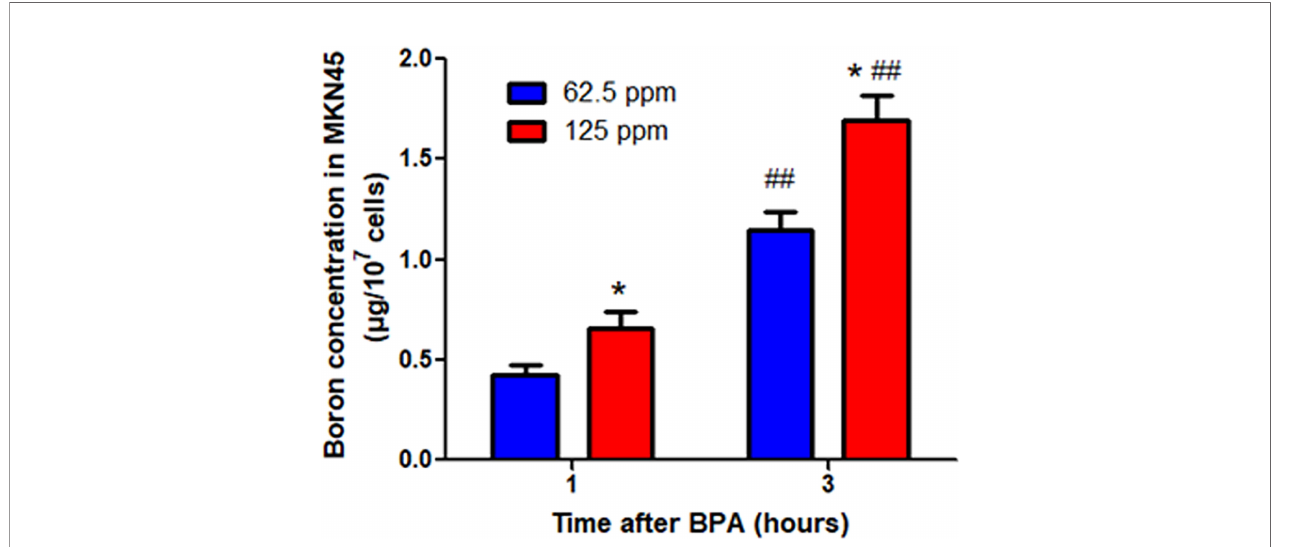
FIGURE 5 | Boron concentration in MKN45 cells. Data were expressed as the means ± SD. N = 4. * p < 0.05 compared at the same time; ## p < 0.01 compared at the same